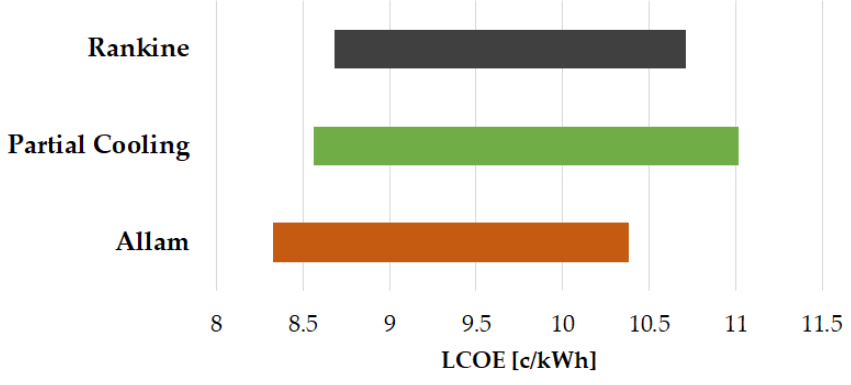
Figure 9. Range of Levelised Cost of Energy ( LCoE ) for CSP plants based on different power